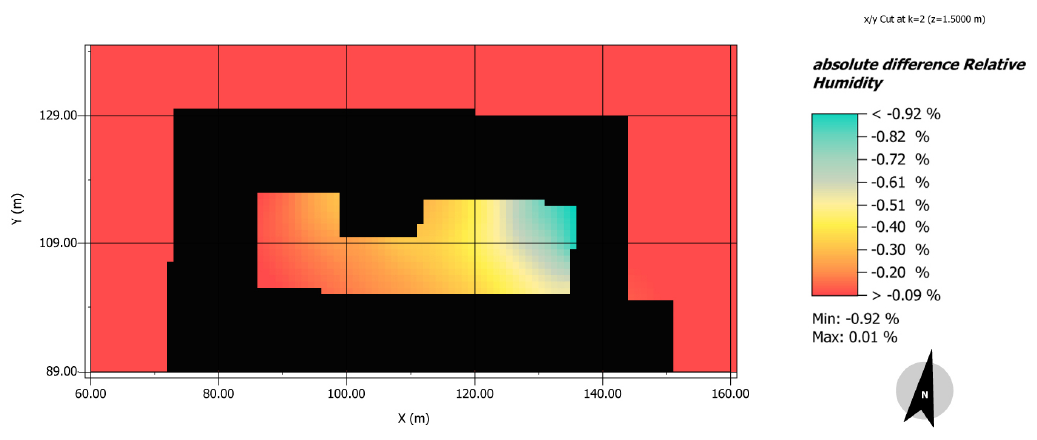
Figure 20. The initial state and creepers roofing scenario air temperature difference in vertical cross section on the east–west axis from the north side view. Figure by authors.